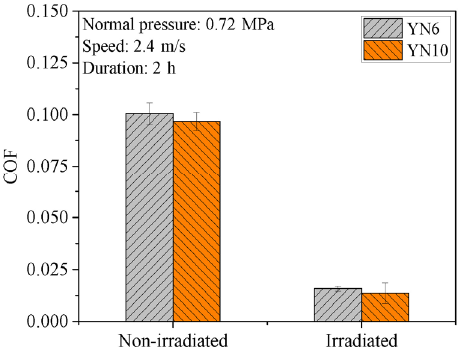
Fig. 6 Friction coefficient between graphite and non-irradiated/ irradiated WC-Ni surface under water